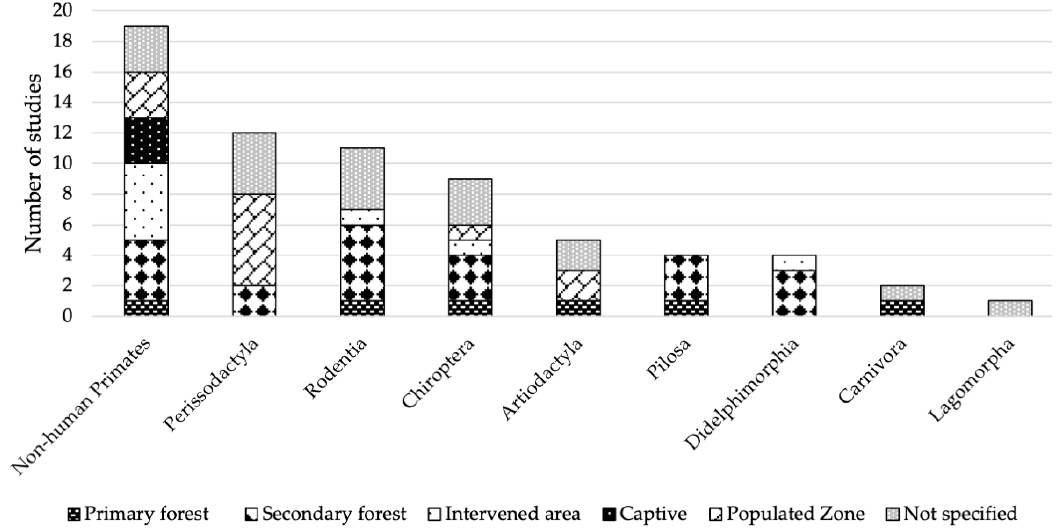
Figure 7. Habitat types with positive records of arboviruses in mammalian orders in the Neotropics.